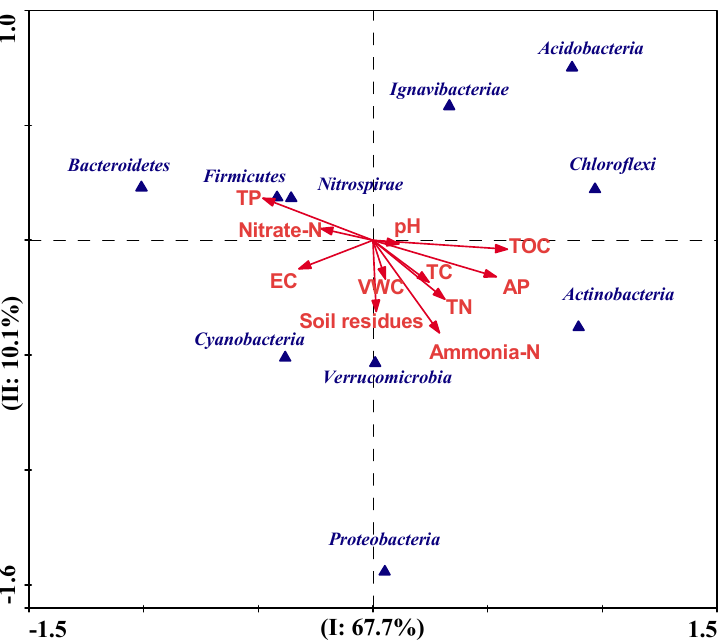
Figure 8. Redundancy analysis (RDA) between the 10 dominant phyla and 11 soil factors.